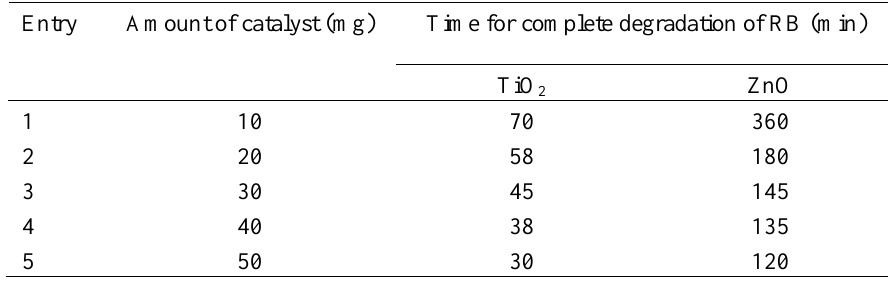
Table 1. Effect of the Amount of Catalyst on the Time for Complete RB Degradation